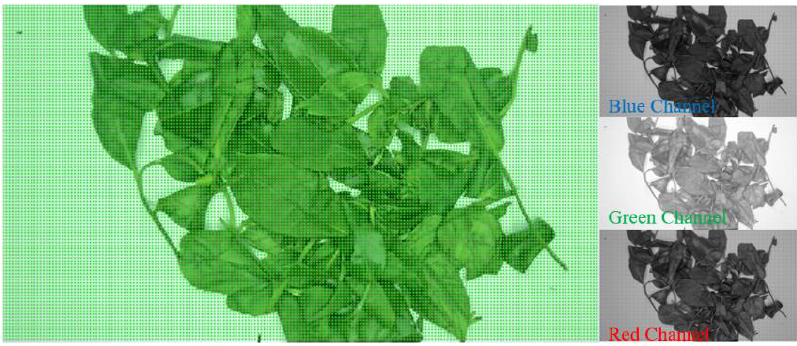
Figure 3. Interpretation of the lightness and darkness of the fixation image.